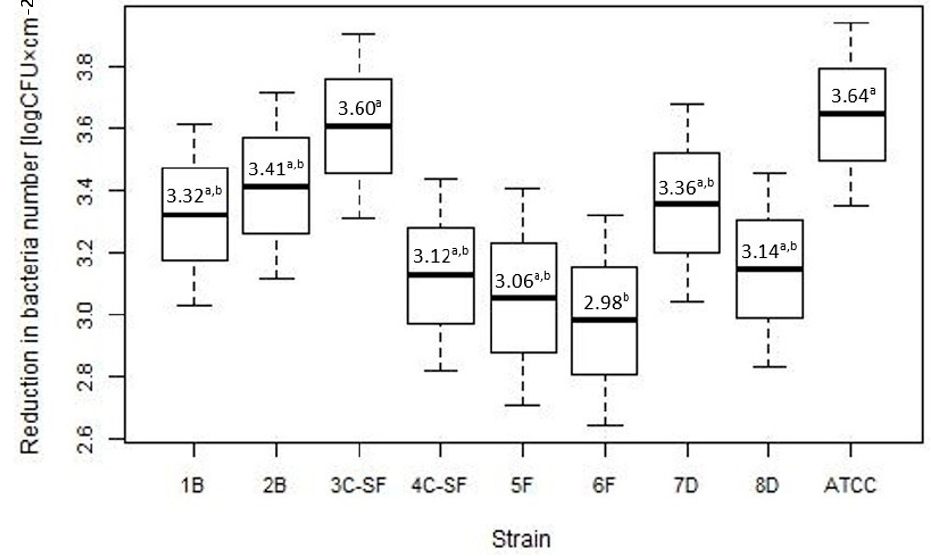
Figure 2. Reductions of bacteria numbers reisolated from biofilm for various strains—the boxplots show mean with SE and 95% confidence interval (a, b, c: differences between values marked with different letters are statistically significant). 1B, 2B—strains from blood, 3C-SF, 4C-SF—strains from cerebrospinal fluid, strains isolated from food—2 from fish: 5F, 6F and 2 from dairy products: 7D, 8D, ATCC 19111—reference strain.